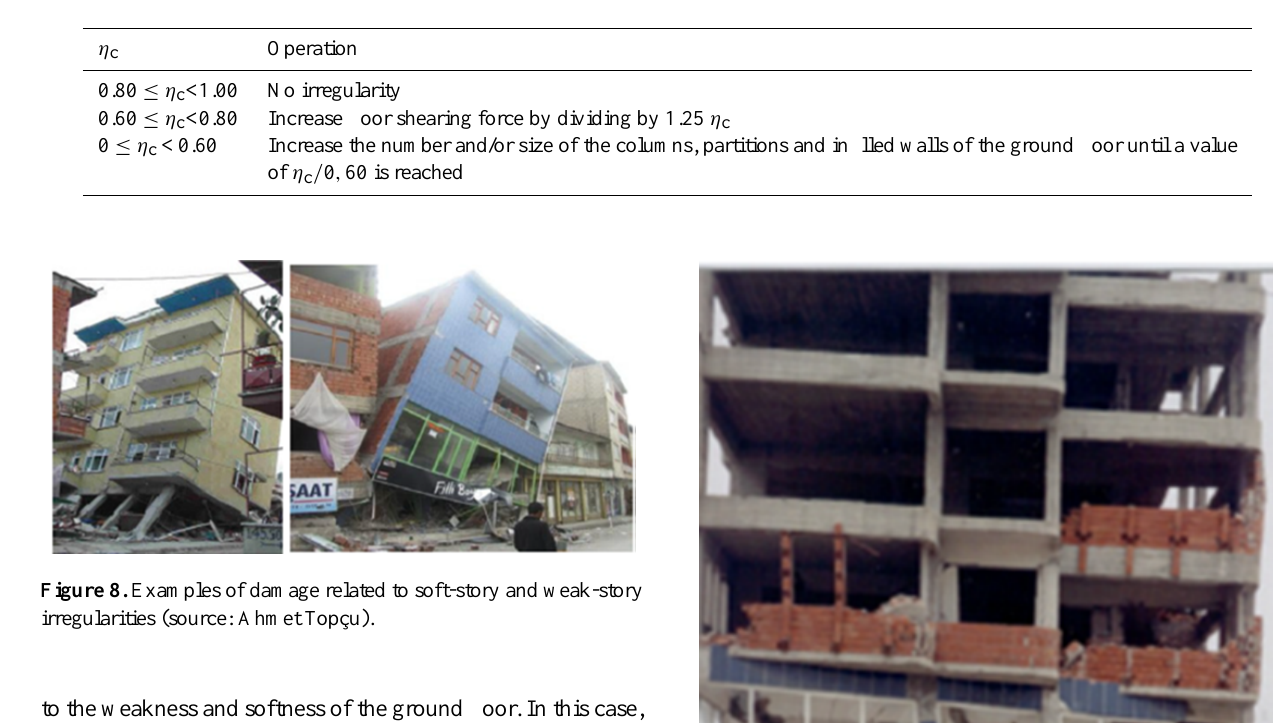
Table 1. Operations according to the weak-story criterion η c .